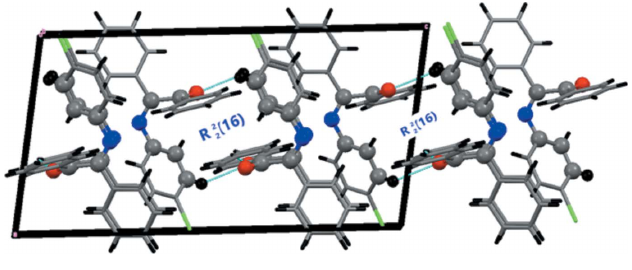
Figure 2 Packing arrangement of the title compound viewed along the c- axis